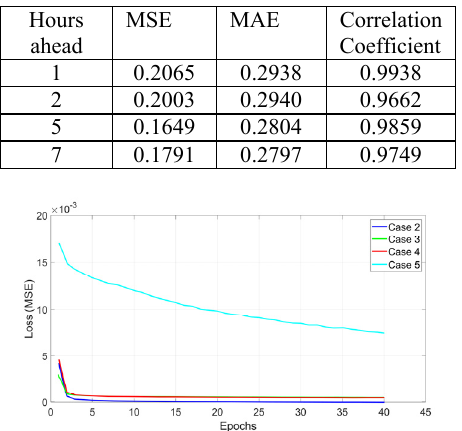
Figure 11. Training MSE plots for Cases 2, 3,4 and 5.